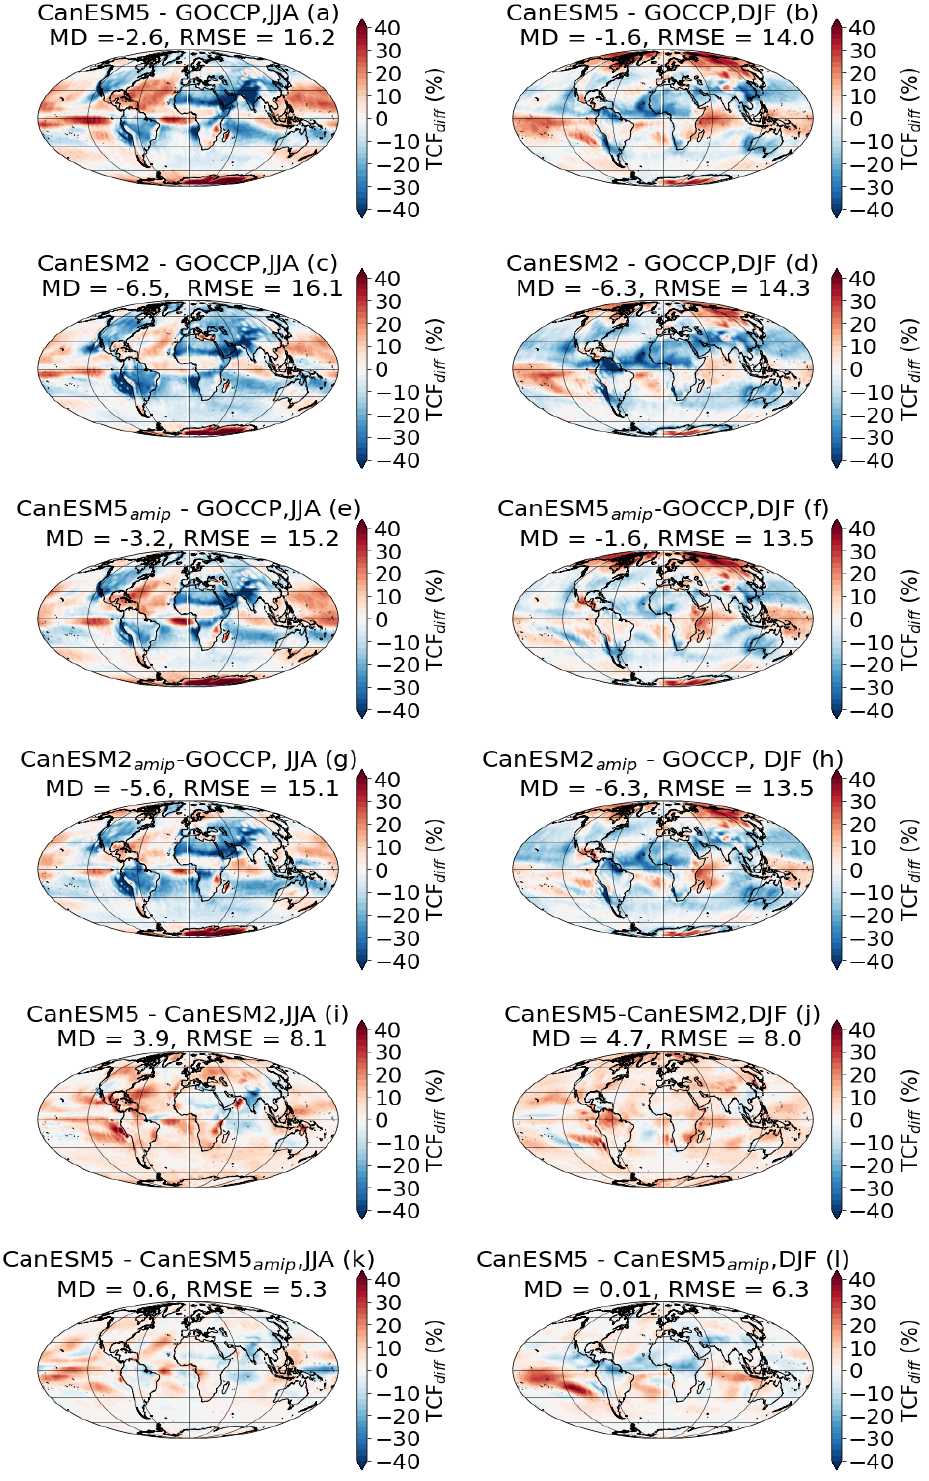
Figure 3. The global maps of model bias in annually and seasonally averaged total cloud fraction (TCF). The mean difference (MD) and root mean square error (RMSE) values are also given.